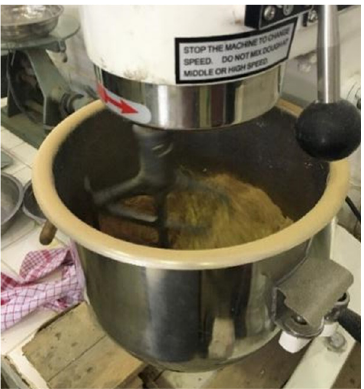
Figure 2: Mixing of UHPC mixture.